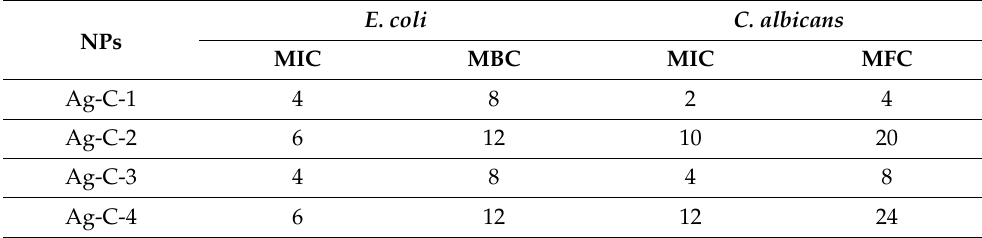
Table 1. MIC and MBC/MFC (mg/mL) values of the NPs against the tested pathogens.